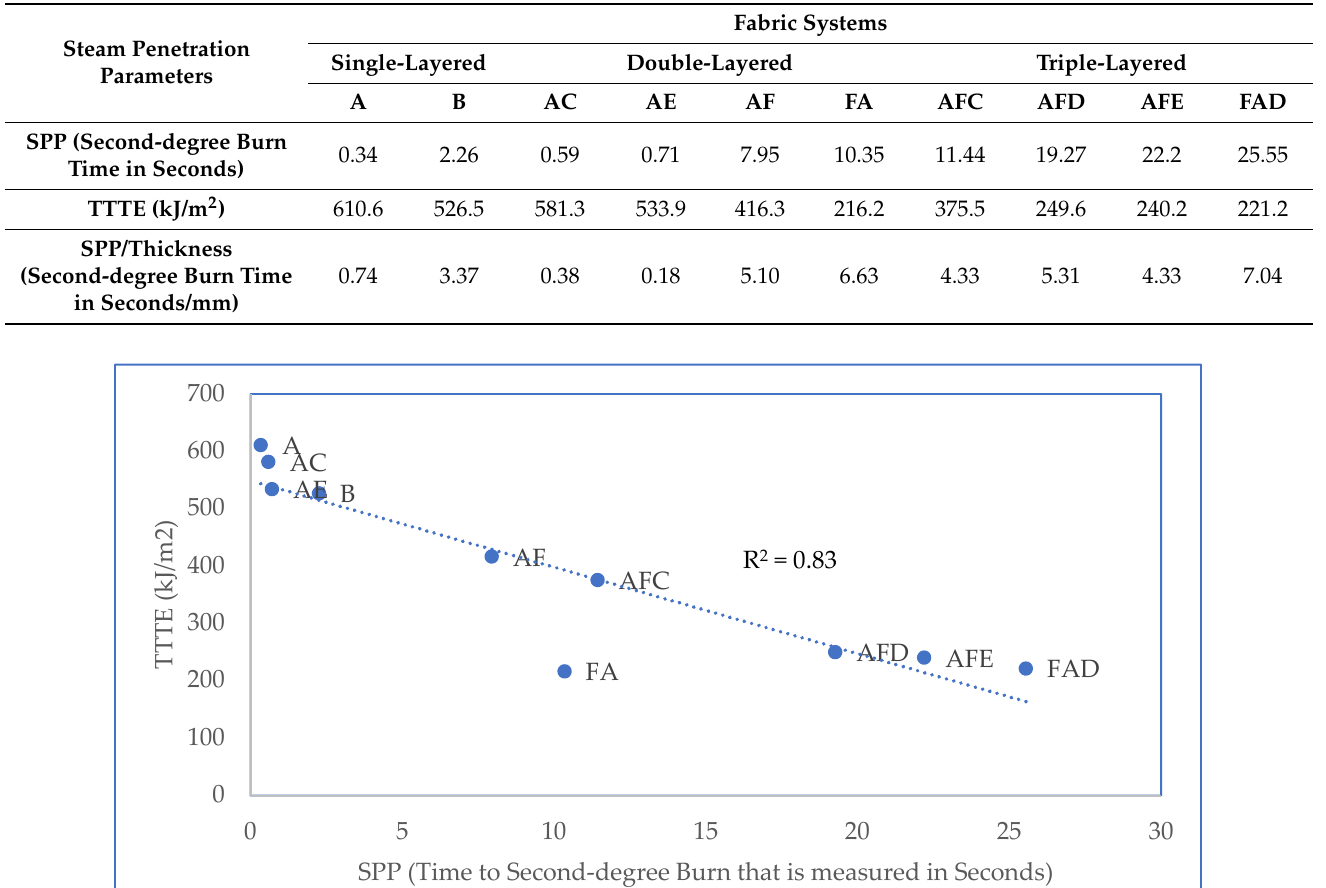
Table 3. Steam penetration parameters of fabric systems.